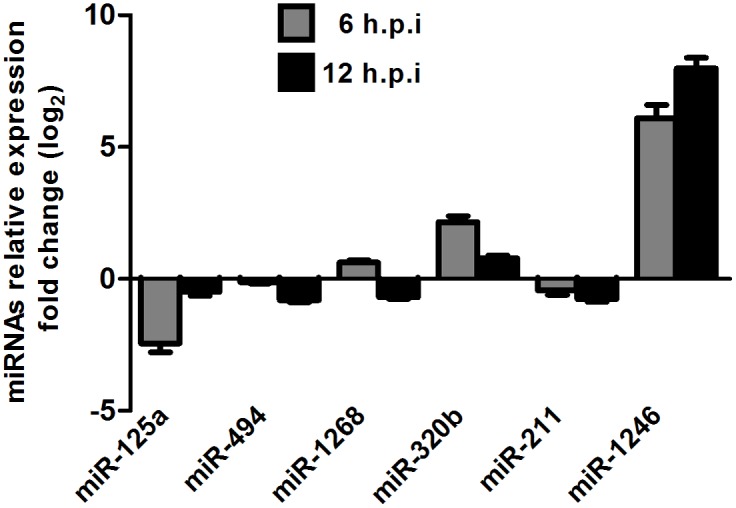
Validation of the microarray data using qRT-PCR.Selected miRNAs in HEV71-infected SH-SY5Y cells were validated using qRT-PCR. The gray bar and the black bar represent 6 and 12 hpi, respectively. The fold change was calculated based on endogenous control normalization using the equation 2−ΔΔCt. ***P<0.0001; values represent the mean±SD.